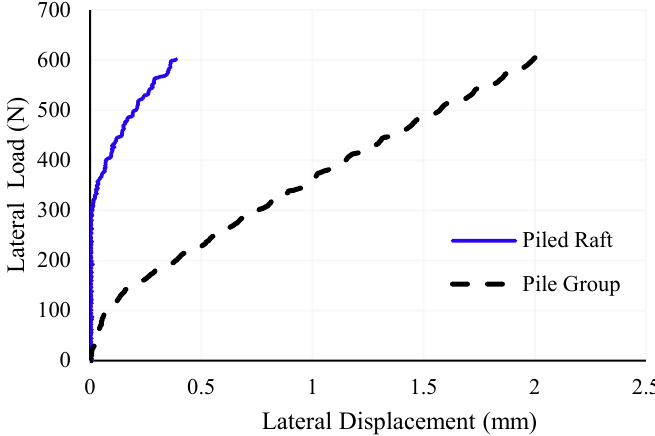
Figure 22. 6-piled raft vs. 6-pile group response under lateral load.